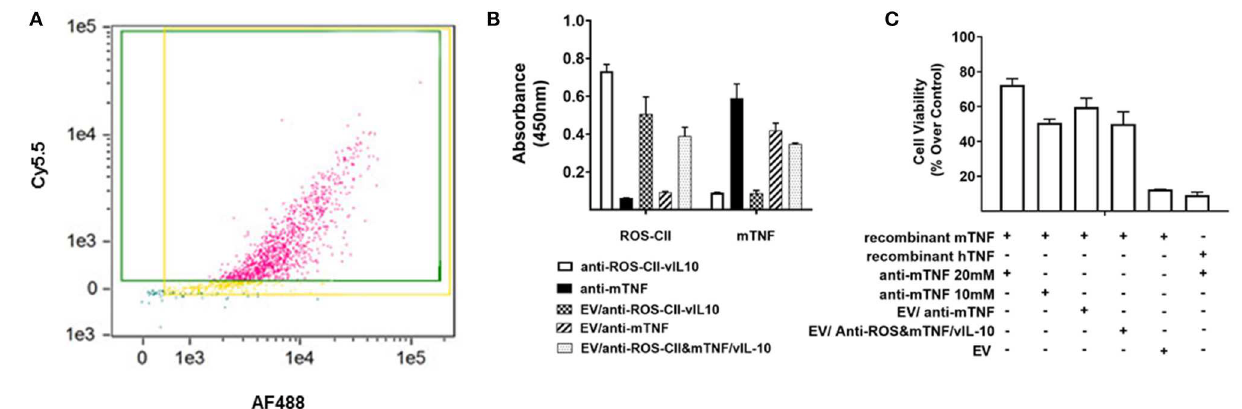
FIGURE 3 | In vitro characterization of EV/anti-ROS-CII enriched with vIL10 and anti-mTNF. Anti-ROS-CII-vIL10 and anti-mTNF were loaded upon PMN EV through fusion with lipid vesicles. (A) Incorporation of anti-ROS-CII-vIL10 labeled with AF488 and anti-mTNF labeled with Cy5.5 upon EV was validated by ImageStream X . Incorporation of both antibodies resulted in 78% of EV staining double positive for both the anti-ROS-CII-vIL10 antibody and the anti-mTNF antibody. (B) ELISA plates were coated with recombinant mTNF or ROS-CII to test the binding specificity of the antibodies after EV incorporation. Both anti-ROS-CII and anti-mTNF embedded on the EV retained their specific binding to ROS-CII and mTNF, respectively. (C) The efficacy of anti-mTNF-enriched EV to inhibit mouse recombinant TNF-induced cell death in L929 cells was tested by MTT assay. Inhibition of cell death was evident only in EV/anti-mTNF and EV/anti-ROS-CII&mTNF/vIL-10. L929 cell death induced by human TNF (hTNF) was not inhibited by anti-mTNF. Data shown as mean ± SEM of n = 3, p < 0.0001. Data were analyzed by one-way ANOVA with Tukey post-hoc